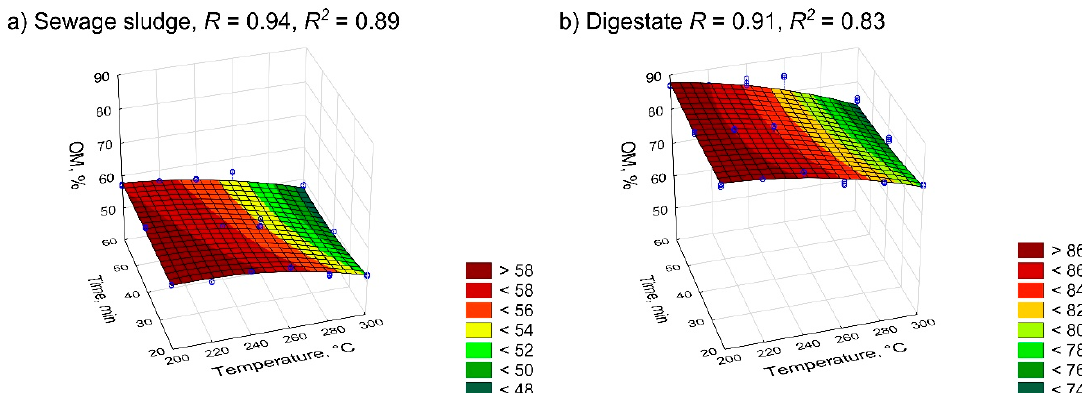
Figure 7. The influence of torrefaction temperature and residence time on the organic matter content in CSF from ( a ) sewage sludge and ( b ) digestate. R —correlation coefficient; R 2 —determination coefficient.